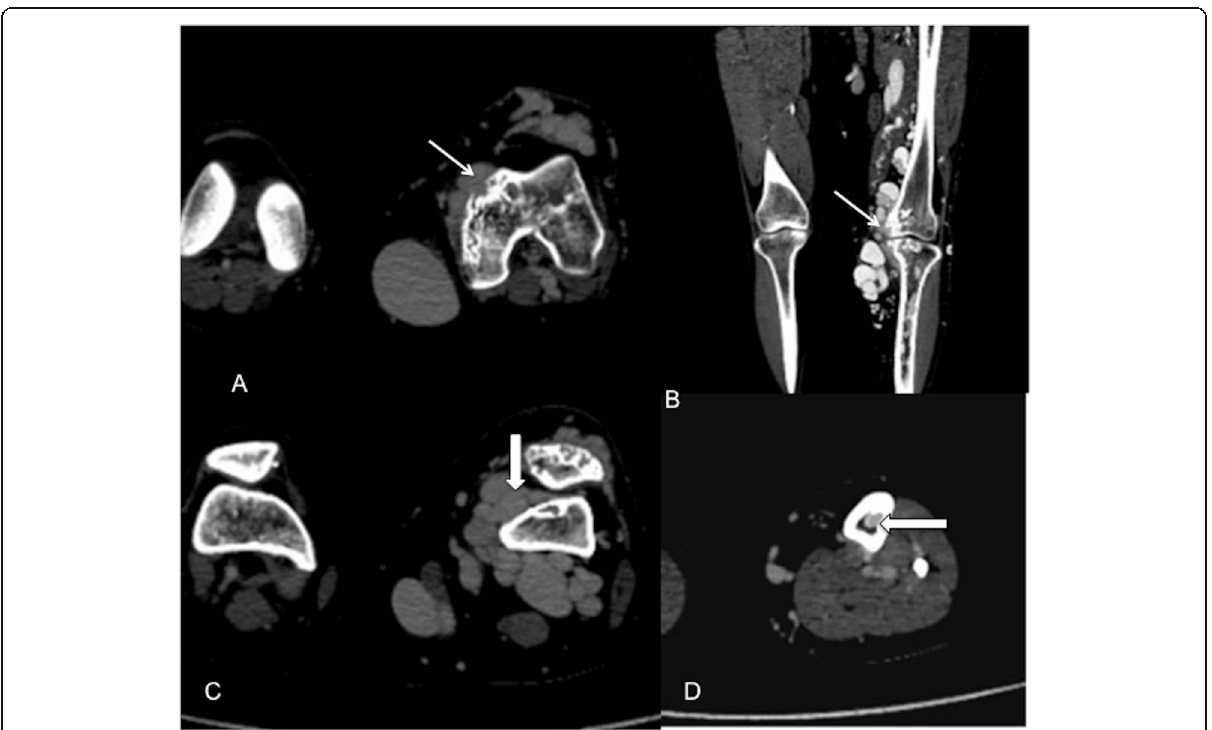
Fig. 3 a – d Axial and coronal contrast-enhanced CT images showing hypertrophy of subcutaneous tissue of the left thigh with multiple dilated venous channels in subcutaneous and intermuscular planes (predominantly in anteromedial distribution) with extension into patellofemoral joint space ( c ; solid arrow). These varicous channels are seen causing cortical bony erosions ( a , b ; arrows) as well as frank intraosseous extension ( d , solid